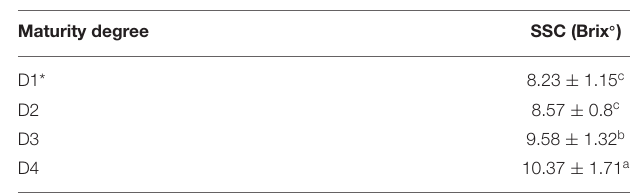
TABLE 1 | Statistical analysis of the measured SSC values of strawberries of different maturity degrees ( p <